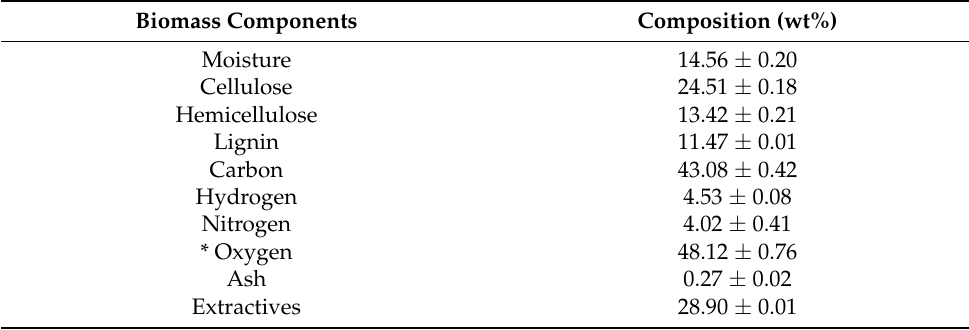
Table 1. Compositional and elemental analysis results from untreated coffee